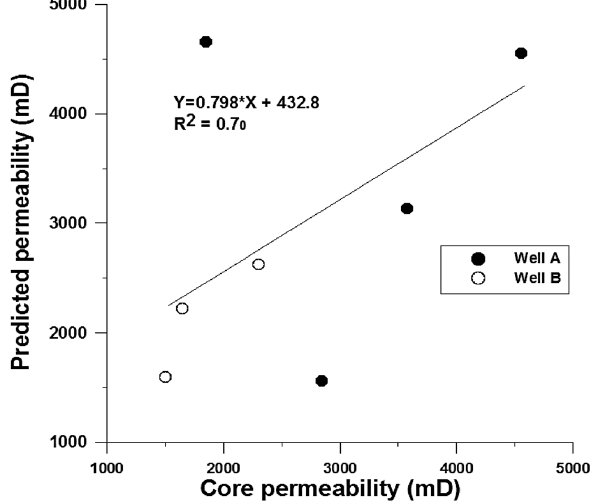
Fig. 7 Crossplot between predicted permeability from Buckles’ approach and core permeability for the Well-A and Well-B at selected depth